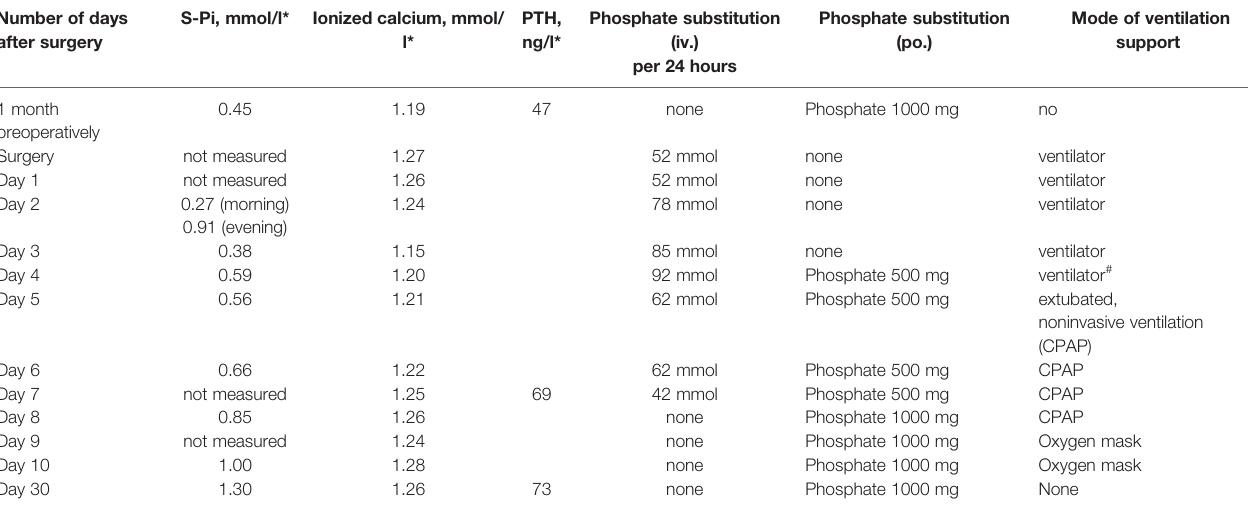
TABLE 2 | Serum phosphate, ionized calcium and PTH concentrations, phosphate substitution and during 10-day postoperative intensive care. Number of days S-Pi, mmol/l* Ionized calcium, mmol/ after surgery